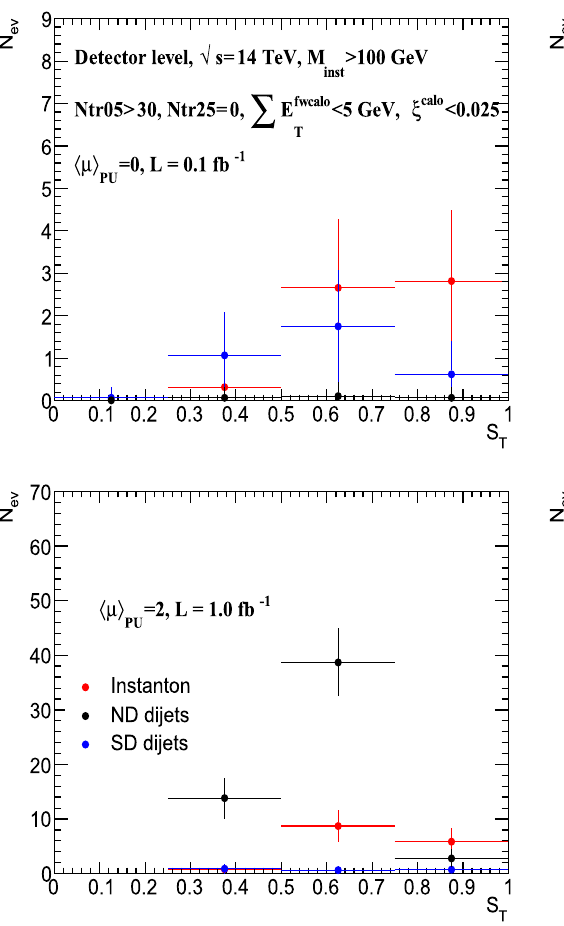
Fig. 4 Distributionsofexpectedeventyieldsasfunctionsoftransverse sphericity at detector level for instanton signal from proton–Pomeron collisionsgeneratedbyRAMBOfor M inst > 100GeVandbackgrounds from ND dijets and SD dijets generated by PYTHIA 8.2 after applying